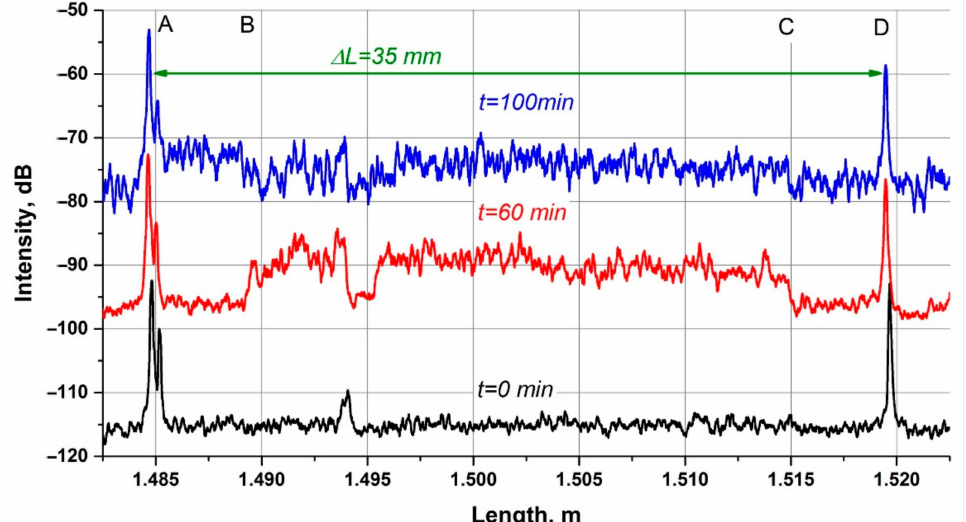
Figure 8. Typical trace of the IOM studied at different moments of the thermal cycle. Traces are shifted relative to each other by 20 dB.